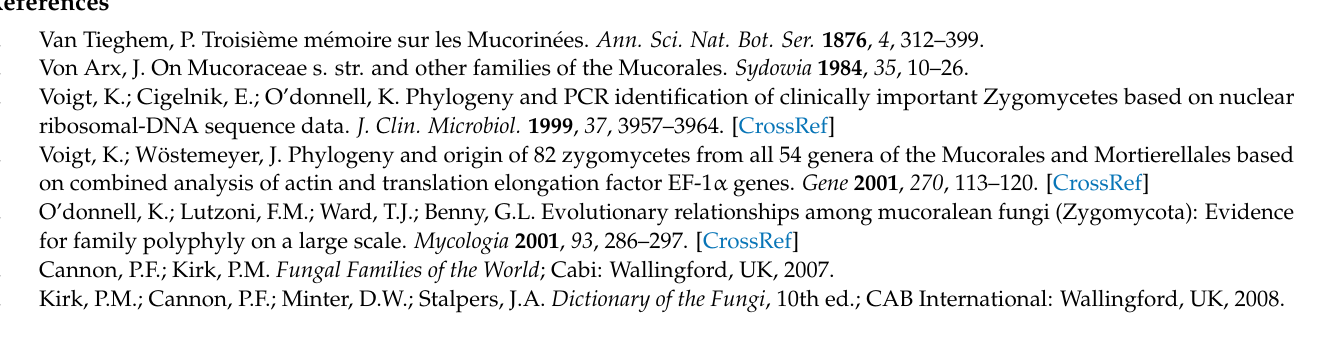
Table S1: Top hits for the new species based on BLAST search for ITS sequences from type